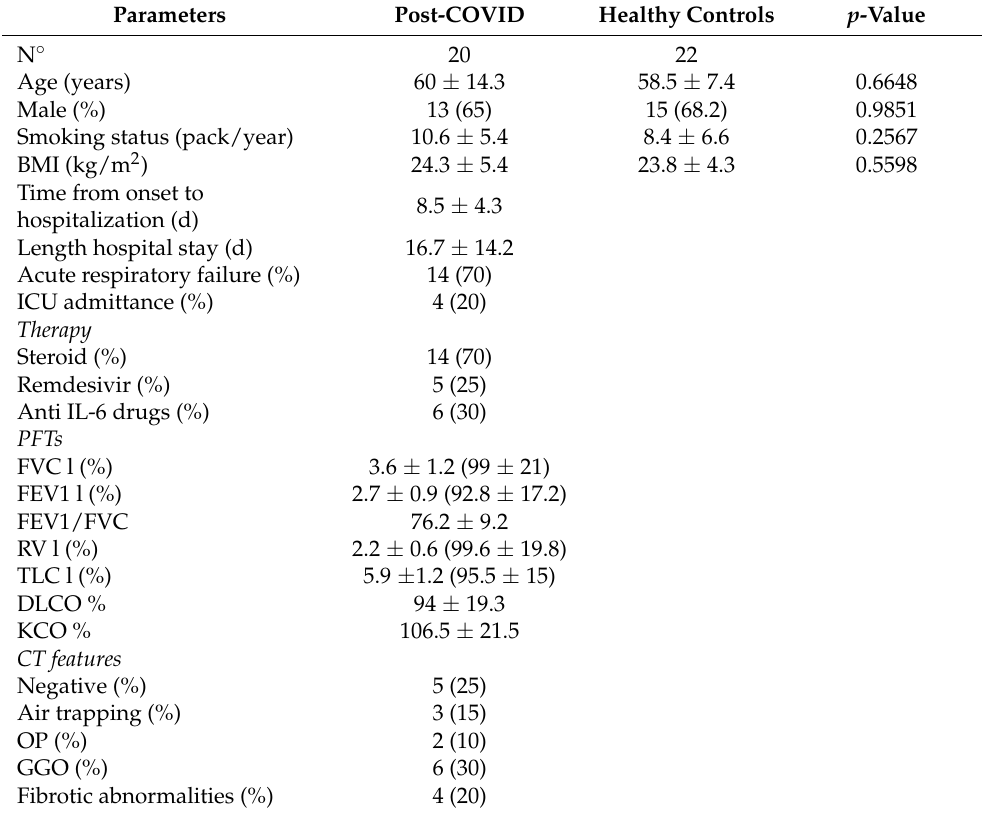
Table 1. Demographic, functional and predominant radiological features of COVID-19 patient cohort. Parameters Post-COVID Healthy Controls p